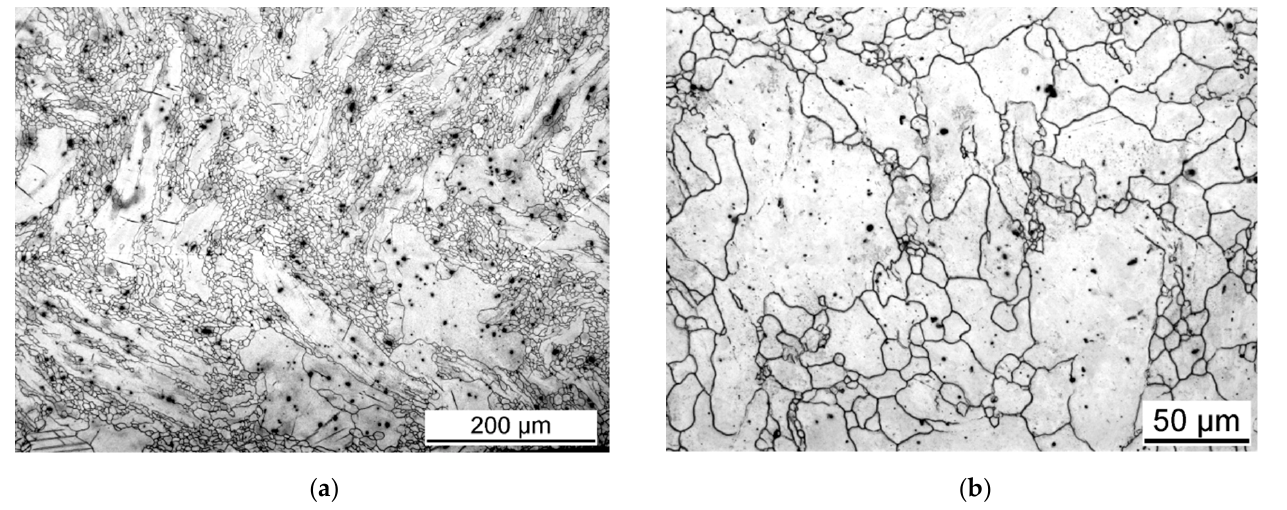
Figure 2. Microstructure of the initial (extruded) condition taken from the section perpendicular to the extrusion direction ( a ), with higher magnification of the same place ( b ).